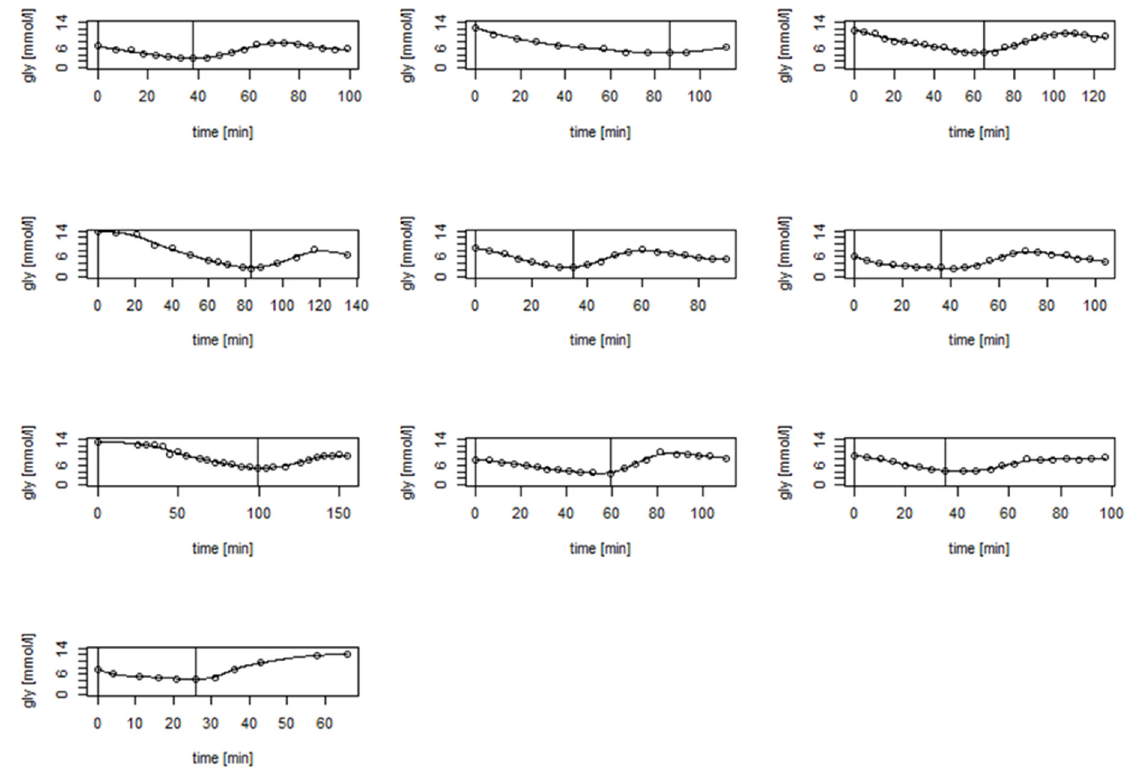
Figure 2. The curves of glucose concentration values of all participants during the study. The first vertical line represents the beginning of the exercise, and the second one represents the end of exercise and ingestion of 20 g of glucose.